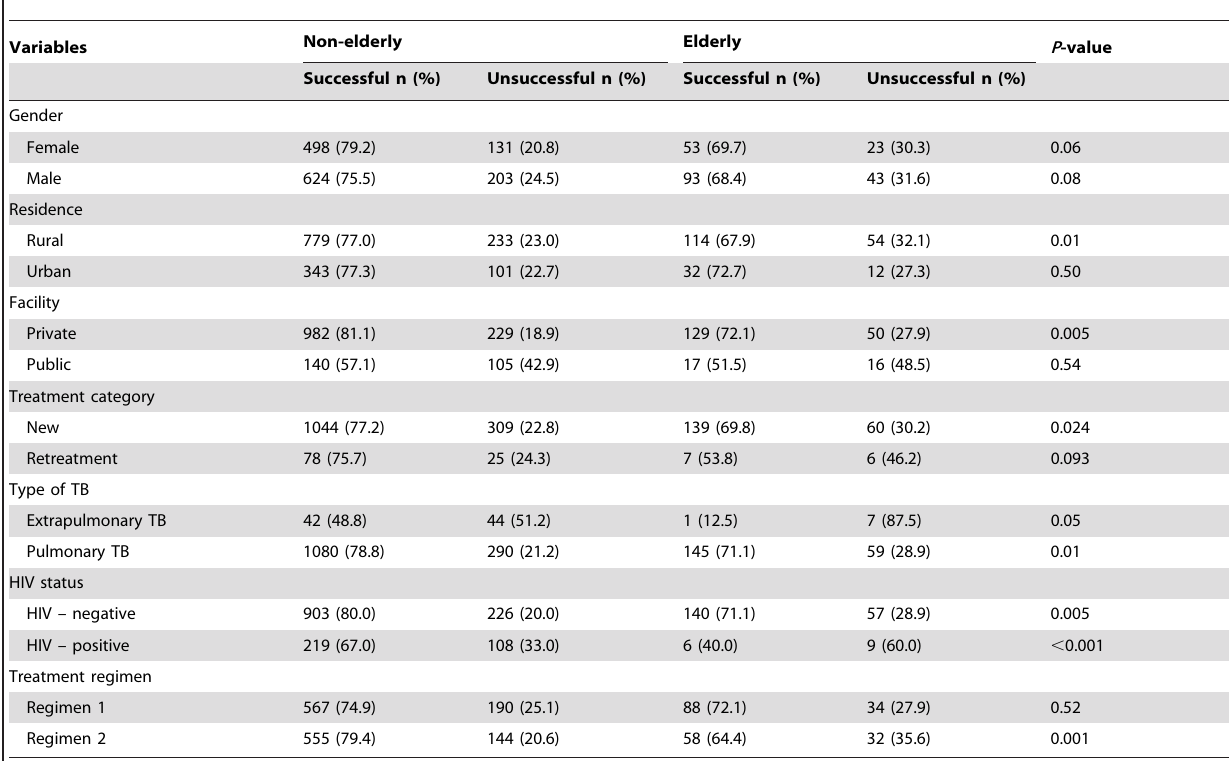
Table 3. A comparison of treatment outcomes between elderly and non-elderly TB patients stratified by demographic and clinical characteristics, Nigeria,